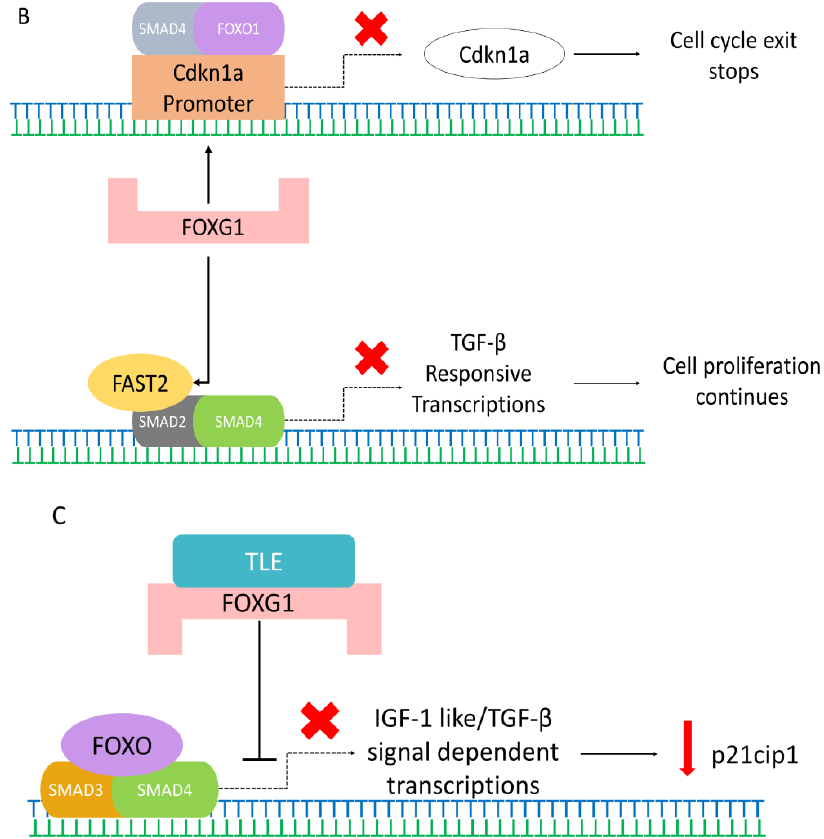
Figure 2. Possible pathways of FOXG1 controlling the different mechanisms in the cell. ( A ) BMI1 (green) interacts and cooperates with FOXG1 promoter (orange), which initiates FOXG1 expression. This interaction also controls cell self-renewal, proliferation, differentiation, and tumor growth. Simultaneously, it also inhibits cell cycle inhibitors p21 and p16. ( B ) FOXG1 (pink) inhibits the expression of Cdkn1a by associating and attaching to the SMAD4 (grey) and FOXO1 (purple) complexes at Cdkn1a promoter to prevent the cell cycle exit and stop differentiation. Also, FOXG1 interacts with FAST2 to inhibit the FAST2 (yellow)-SMAD2 (dark grey)-SMAD4 (green) complex formation, thereby repressing the TGF- β responsive transcriptions and allowing cell proliferation. Cross (red) indicate the transcriptional loss. ( C ) TLE-FOXG1 complex represses the FOXO (purple)-SMAD3 (orange)-SMAD4 (green)-mediated transcription of p21cip1 initiated by IGF-1like/TGF- β signal, which inhibits apoptosis while promotes growth and proliferation.